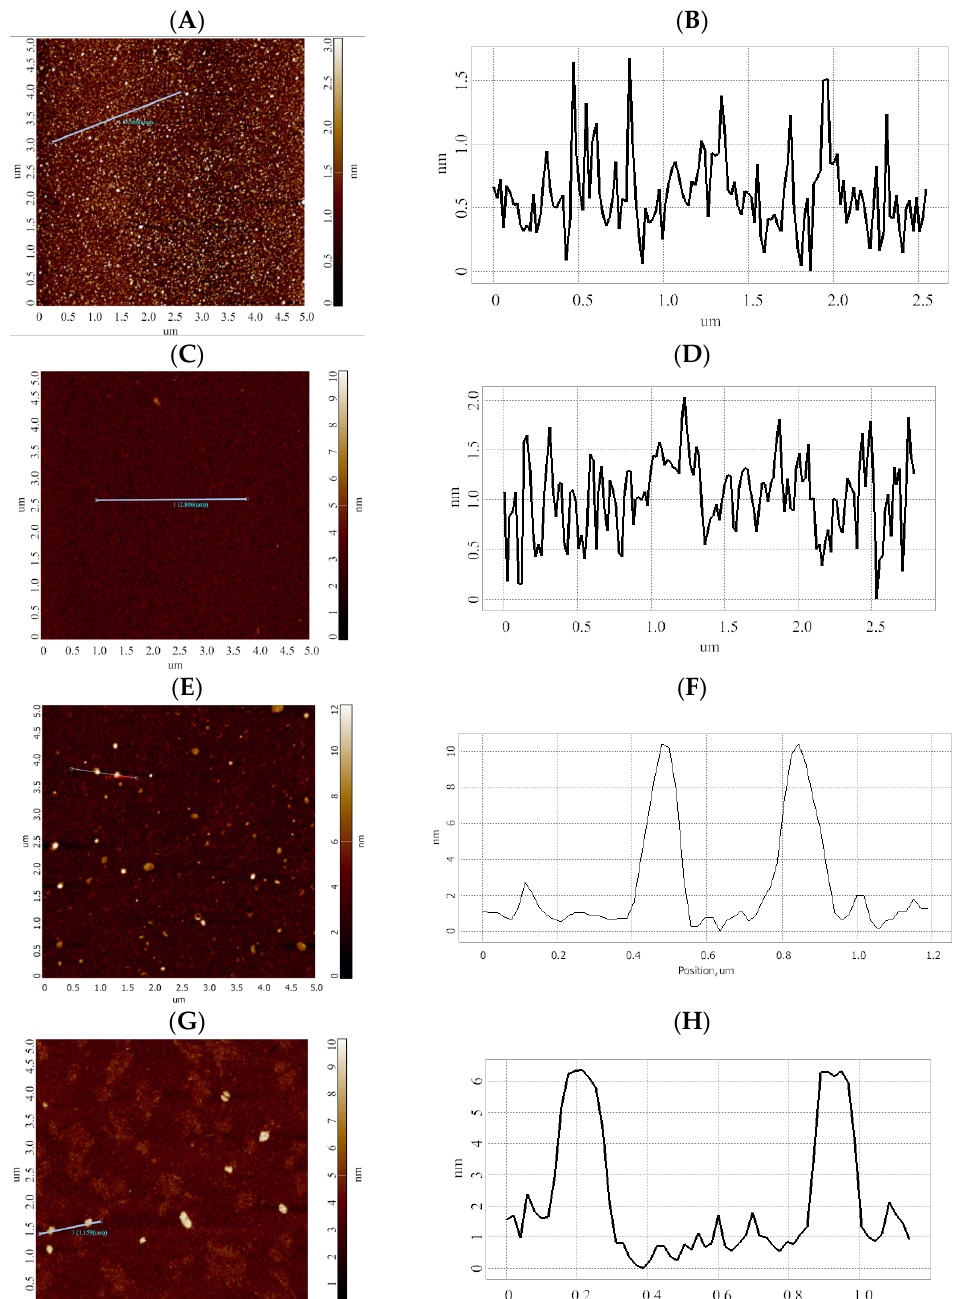
Figure 3. Typical AFM images (left) and cross-section profiles (right) obtained in the sensor areas AFM chip surface after the immobilization of oligonucleotide probes ( A , B ); of the sensor area sensitized with molecular probes specific against microRNA associated with ovarian cancer (non-specific probe, negative control) after the incubation in the sample of ASD patient ( C , D ); after the incubation in the serum of an ASD patient sample #7 ( E , F ); after the incubation in the serum sample #8 of a conditionally healthy child ( G , H ). Left panels display the AFM images, while right panels display cross-section profiles, corresponding to the lines shown in the respective AFM images.